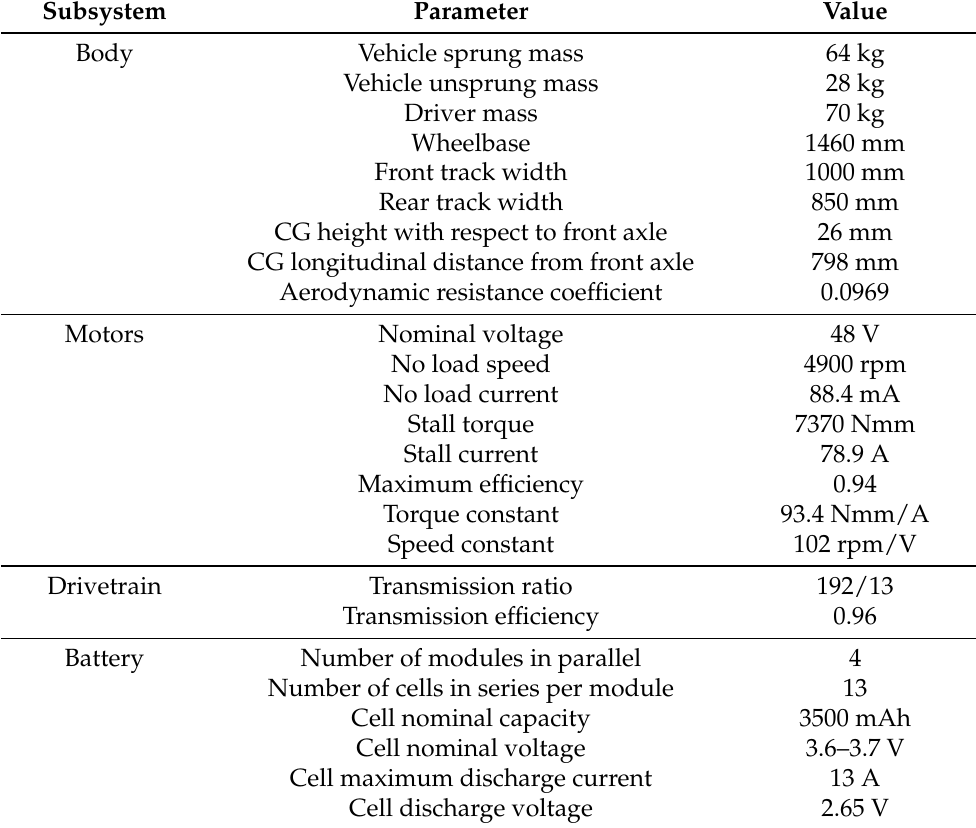
Table 1. Main characteristics of the